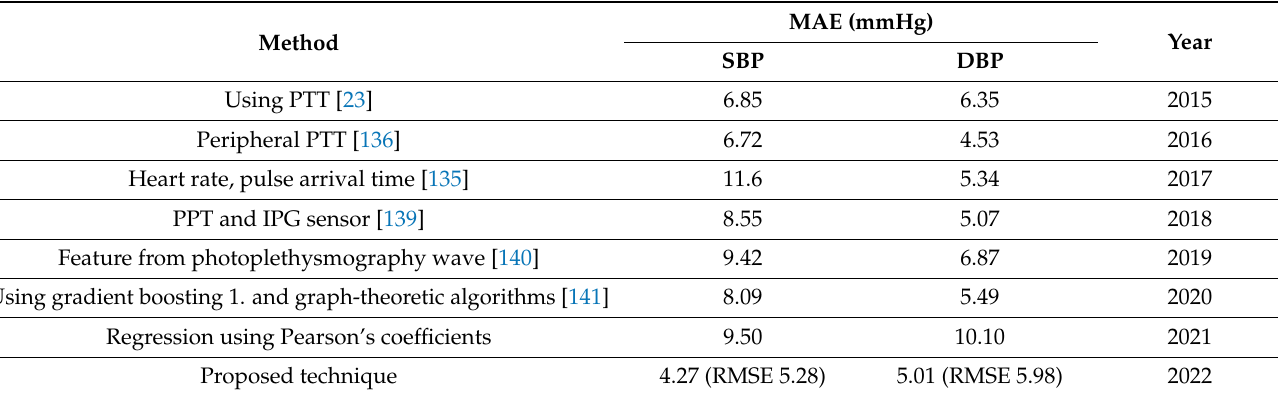
Table 3. Comparing the performance from different contemporary methods of BP